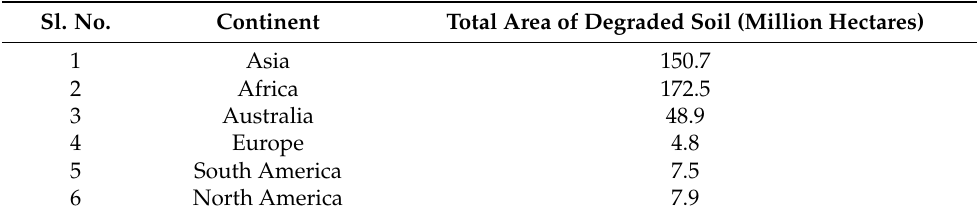
Table 5. Extent of soil degradation in arid soils of different continents; modified from [148]. Sl. No.